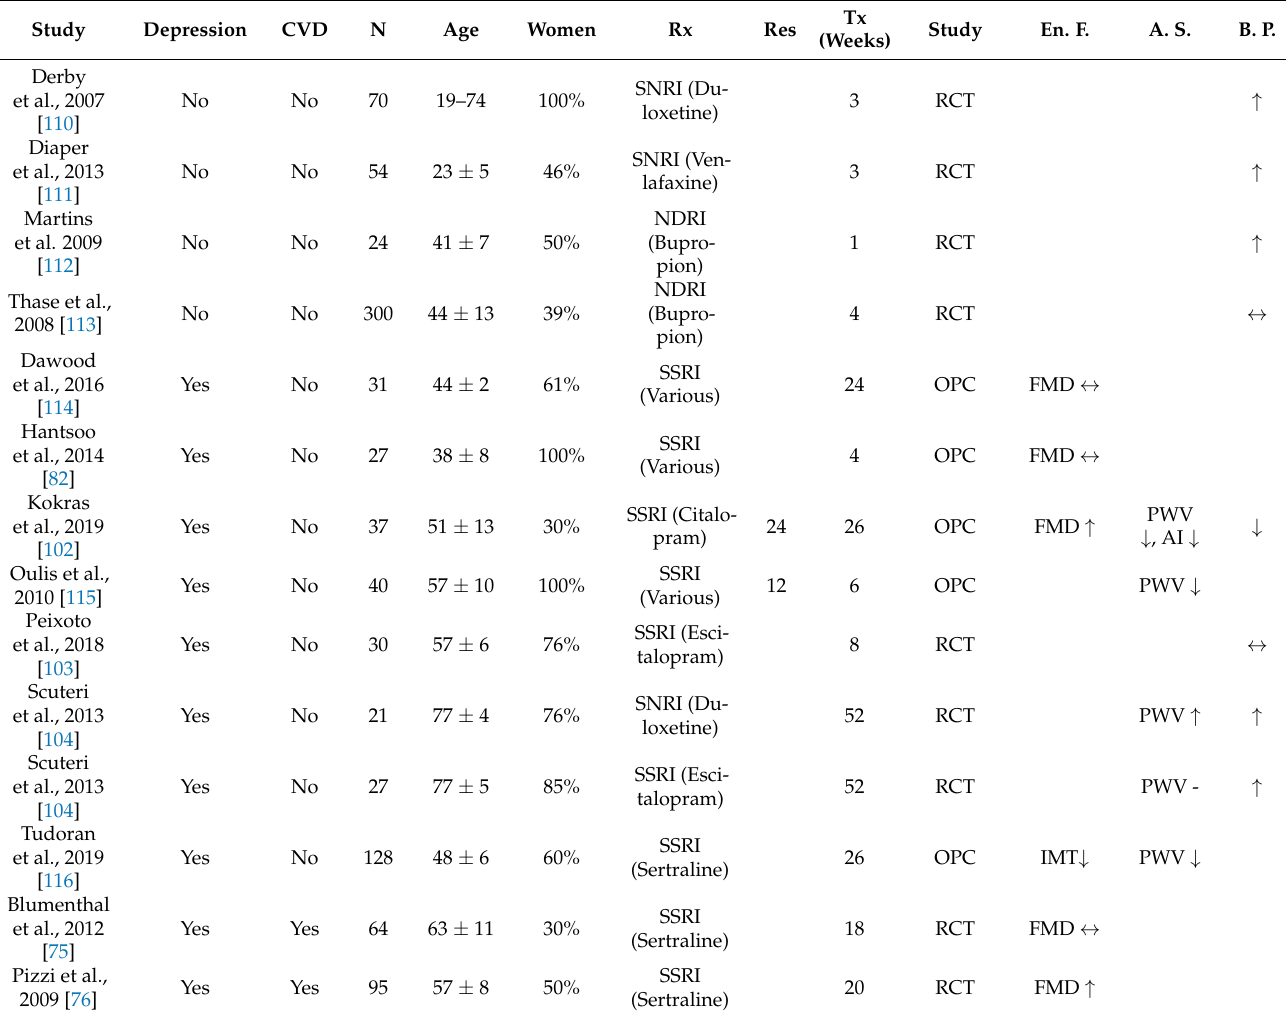
Table 3. The effects of antidepressants on vascular markers: Randomized Controlled Trials (RCTs) and Observational Prospective Cohort Studies